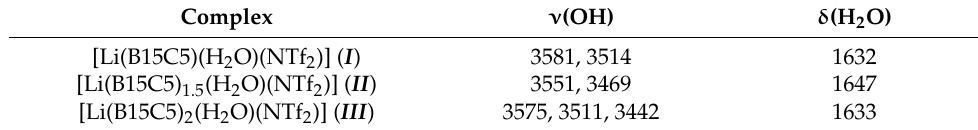
Table 2. Vibration frequencies of coordinated water molecules in spectra ( I–III ) (cm − 1 ).